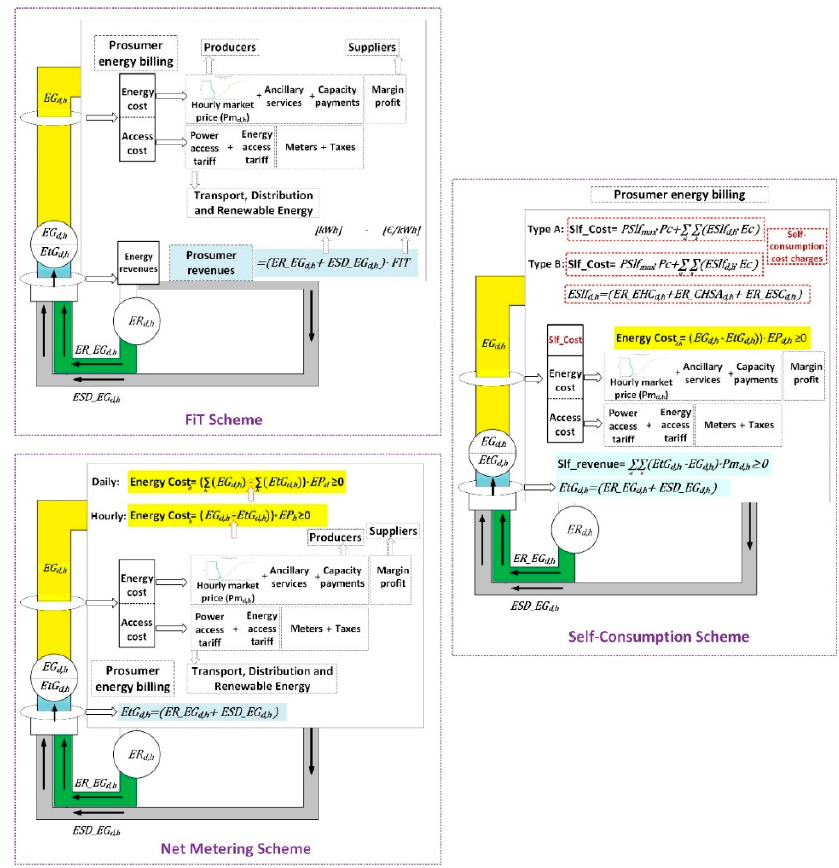
Figure 5. Representation of the prosumer’s billing subjected to the structure of the FiT scheme ( a ), the Net Metering scheme ( b ) and the Self-consumption scheme ( c ). Source: